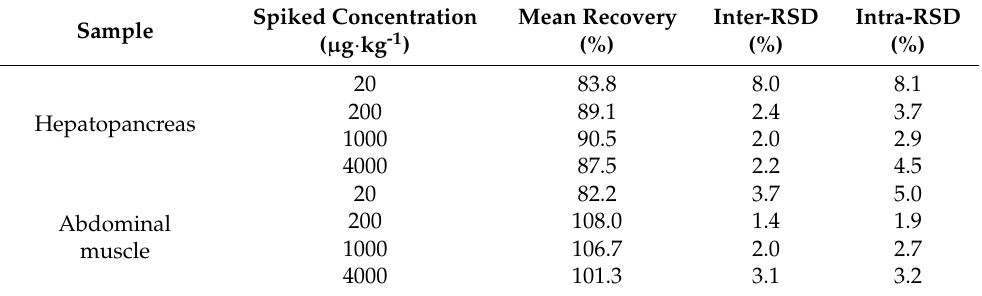
Table 1. Recovery and precision of the ultra-performance liquid chromatography–tandem mass spectrometry method to determine maduramicin in edible crayfish tissues ( n = 6 at each tested concentration, on three consecutive days).